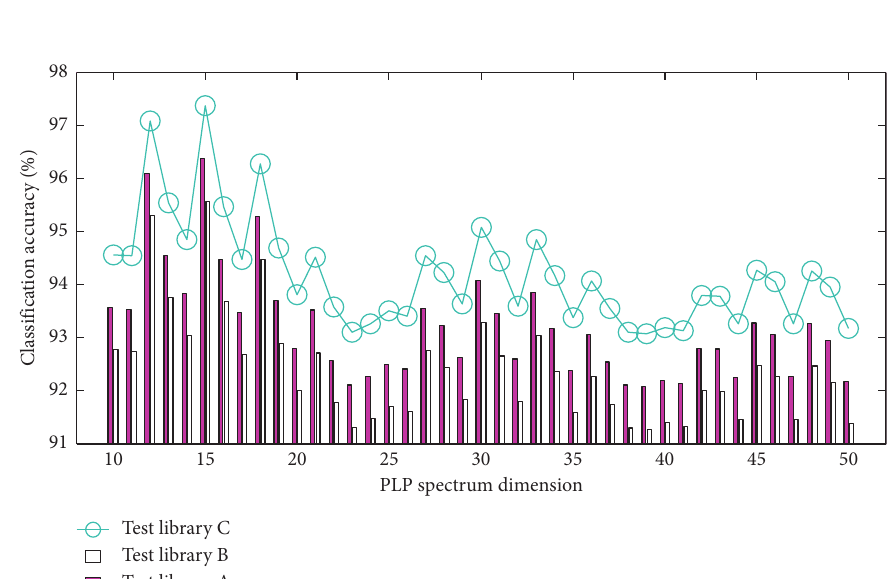
Figure 7: Classification accuracy of different PLP spectrum